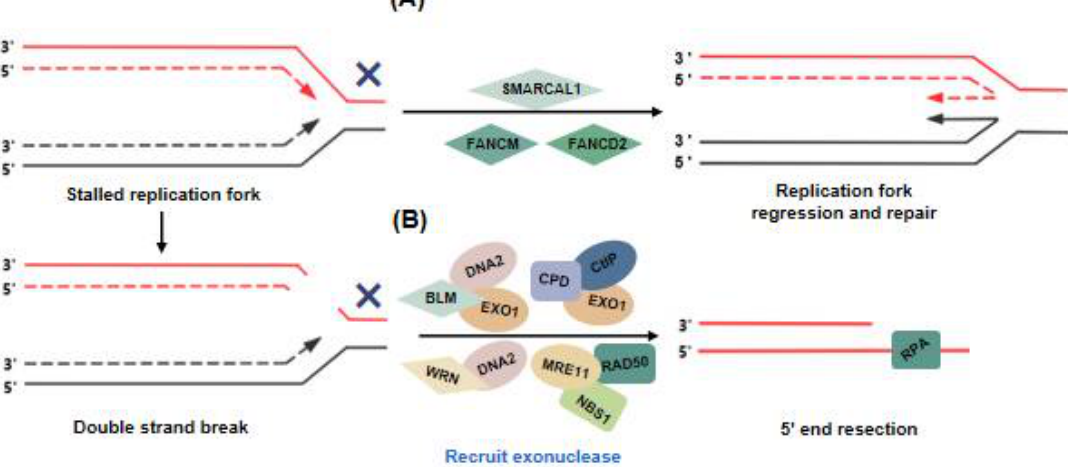
Figure 2. The processing of stalled replication fork at ALT telomeres. ( A ) SMARCAL1, FANCD2 and FANCM protect stalled forks from collapsing and promote replication fork regression and repair. ( B ) The DSBs generated by fork collapse undergo end resection, which is mediated by BLM -DNA2-EXO1, CPD-CtIP-EXO1, WRN-DNA2, or the MRE11-RAD50-NSB1